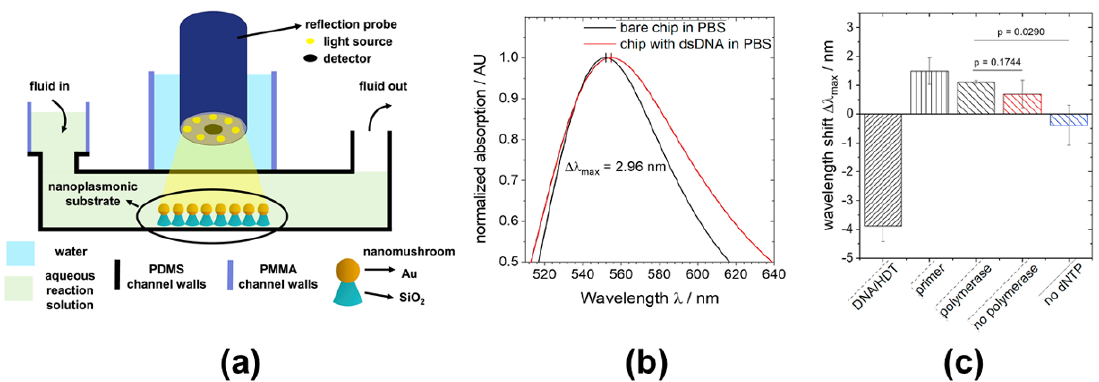
Figure 10. ( a ) Schematic of a DNA polymerase reaction detection platform, which combines a fiber-optic sensor and a microfluidic device with a gold nanomushroom substrate. ( b ) Spectra of bare- and double-stranded 30-mer-DNA-immobilized substrates measured by the fiber-optic-sensor-based polymerase reaction detection platform and ( c ) wavelength shifts according to polymerase reaction steps. The figure in Roether et al. [96] is reprinted with permission from Elsevier.